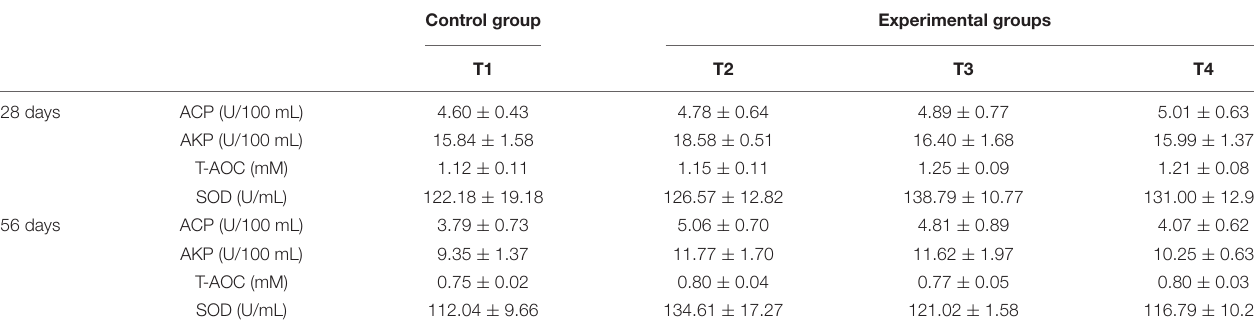
TABLE 3 | Effects of autochthonous probiotics on serum immune index of grouper ( E. coioides ) fed diets with high levels of histamine.